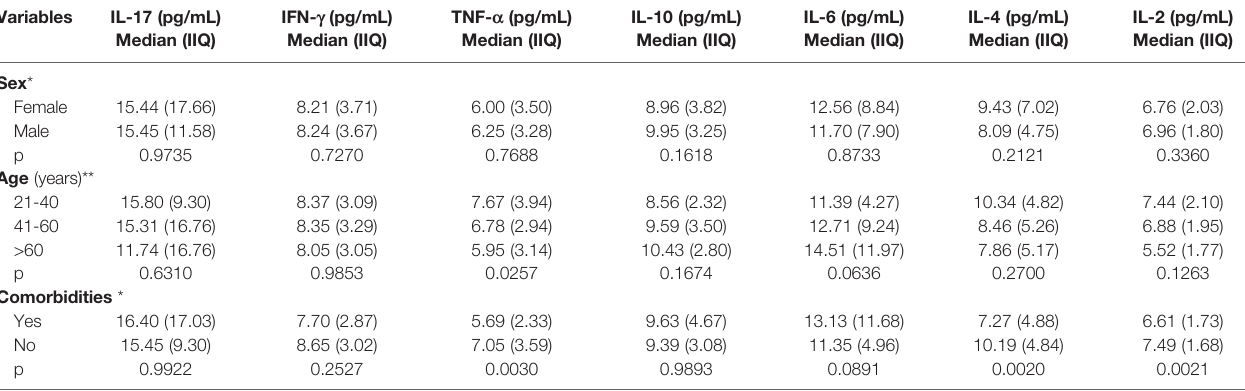
TABLE 3 | Comparison of cytokine levels in relation to epidemiological variables among patients with acute COVID-19.